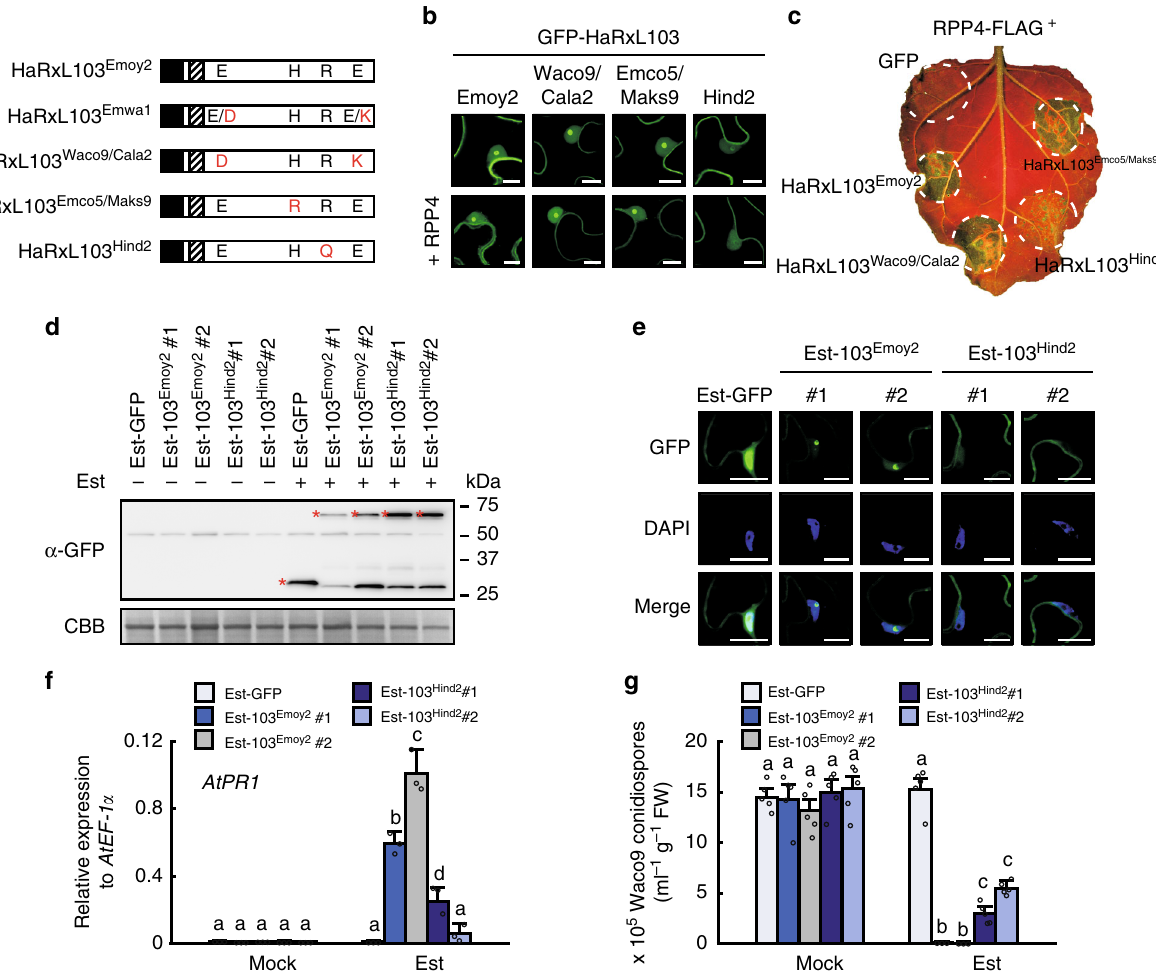
Fig. 3 Effect of mutations in HaRxL103 alleles on in planta subcellular localization and recognition by RPP4 . a Schematic structures of HaRxL103 alleles. Filled and diagonal boxes indicate an N-terminal signal peptide and an RxLR motif, respectively. Red-letter residues indicate polymorphic sites. E, Glu; H, His; R, Arg; D, Asp; K, Lys; Q, Gln. b Subcellular localization of HaRxL103 alleles. GFP-tagged HaRxL103 alleles were transiently (co)expressed